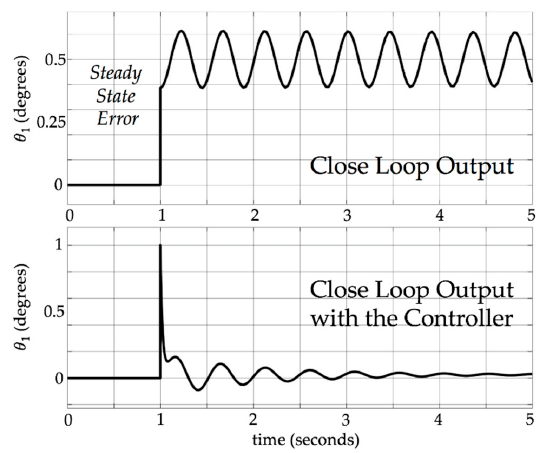
Figure 15. Step transient response of the proportional-integral-derivative (PID) controller ( θ 1 versus time).